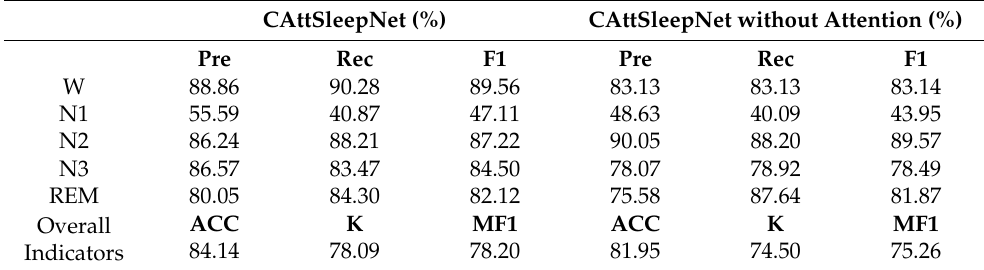
Table 5. Ablation experiments on Fpz-CZ channel of the sleep-edfx-2013